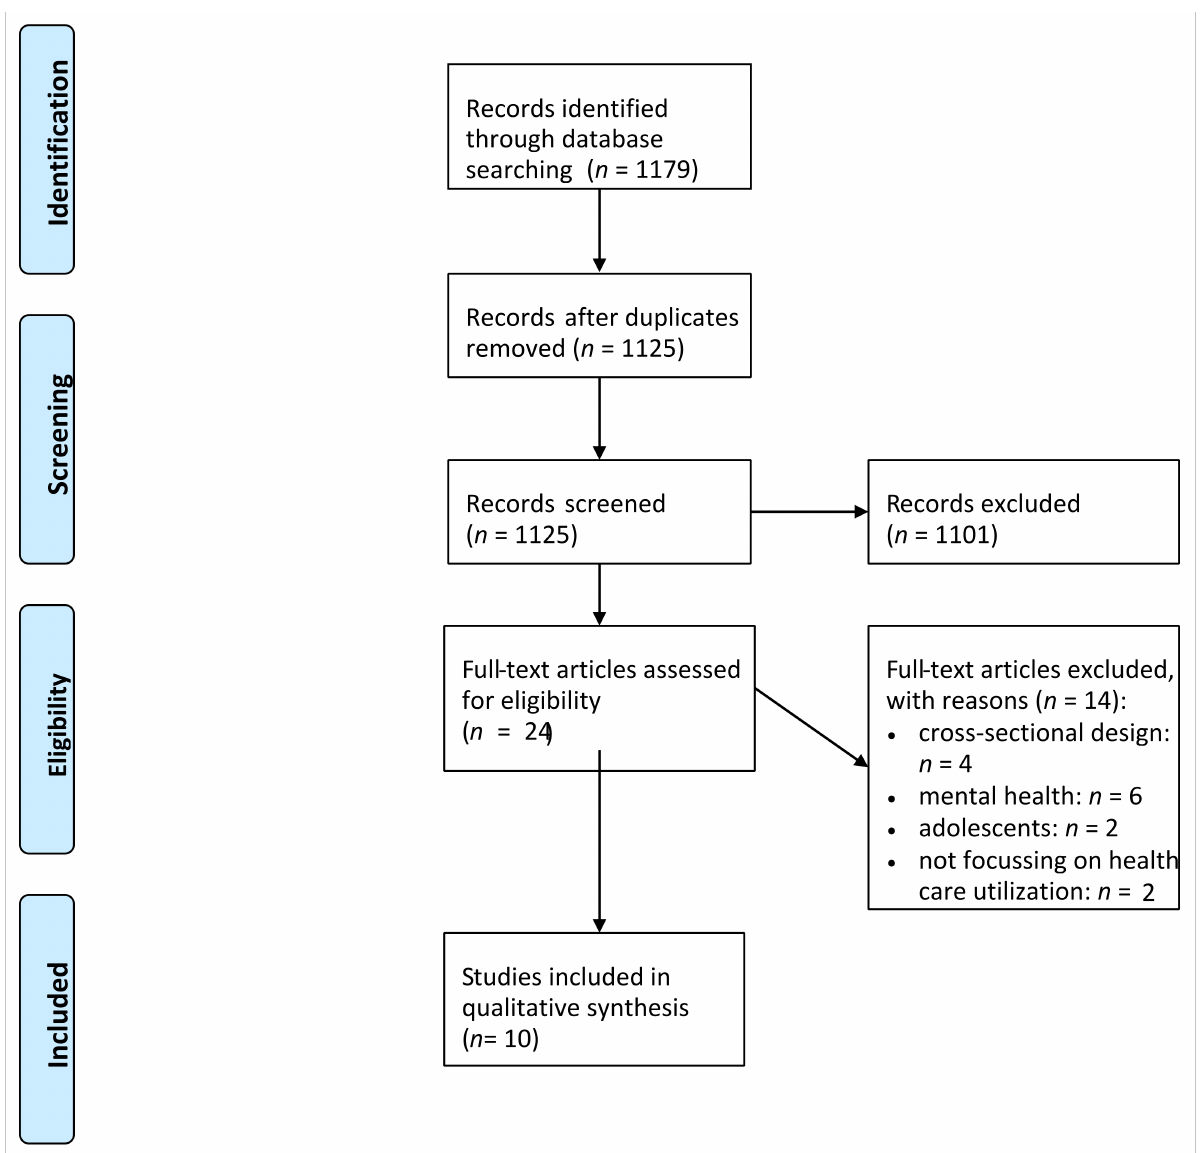
Figure 1. Flow chart. PRISMA 2009 Flow